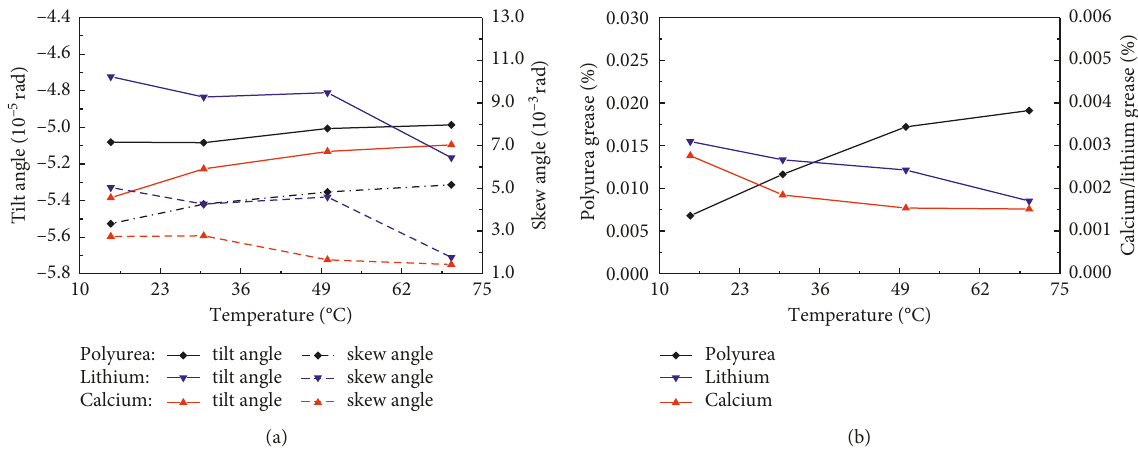
Figure 16: Temperature influence. F